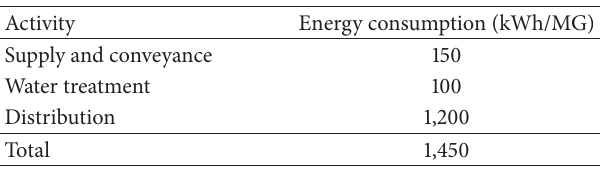
Table 1: Energy consumption in conventional water resources system